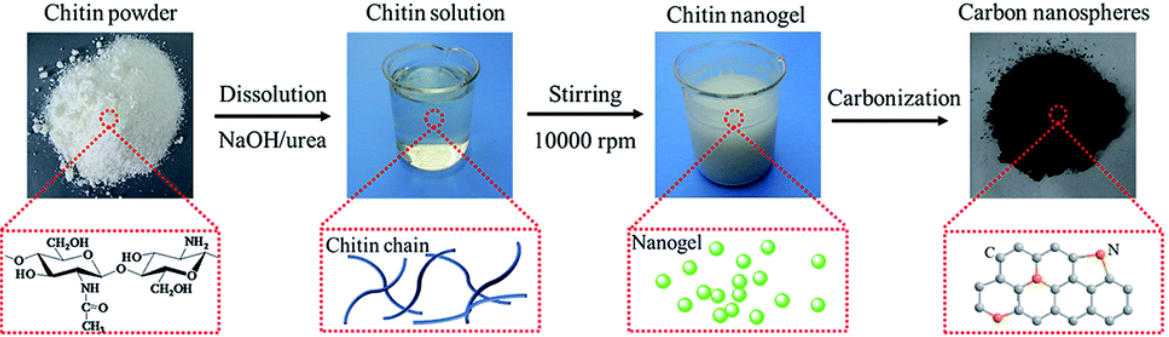
Figure 16. Representation of the formation process for chitin-derived nanospheres. Adapted from reference [96] . This article is an open access article distributed under the terms and conditions of the Creative Commons Attribution (CC BY 3.0) license.